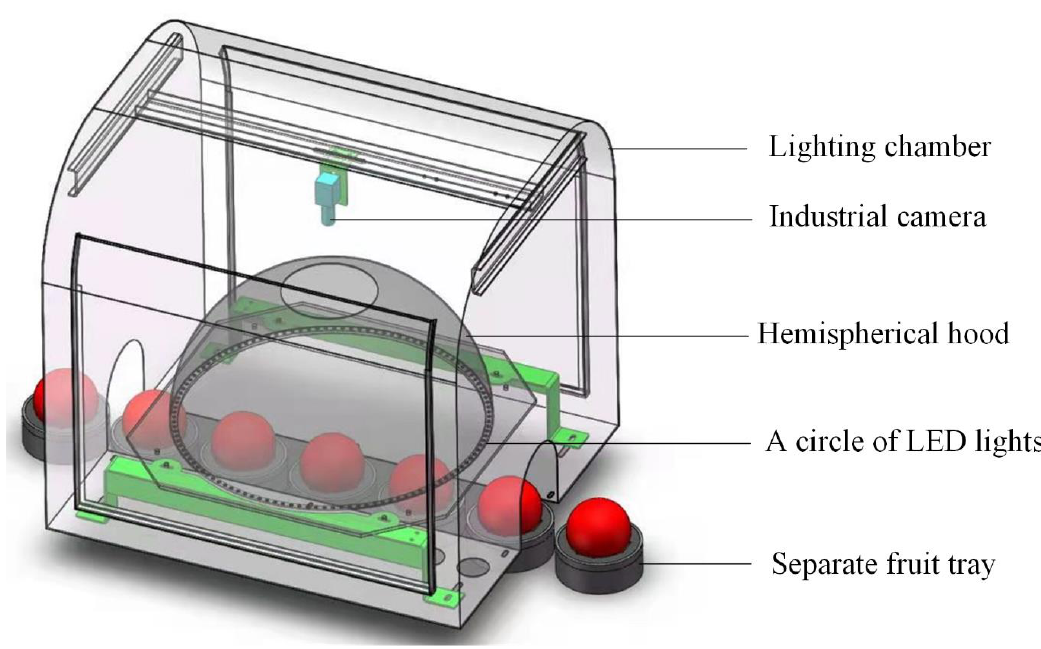
Figure 1. Image acquisition system.